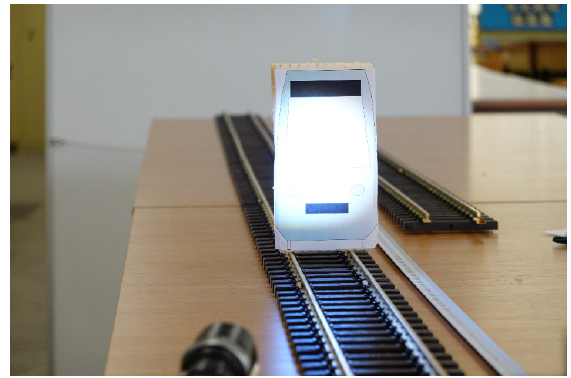
Figure 9. Powerful light on target object.